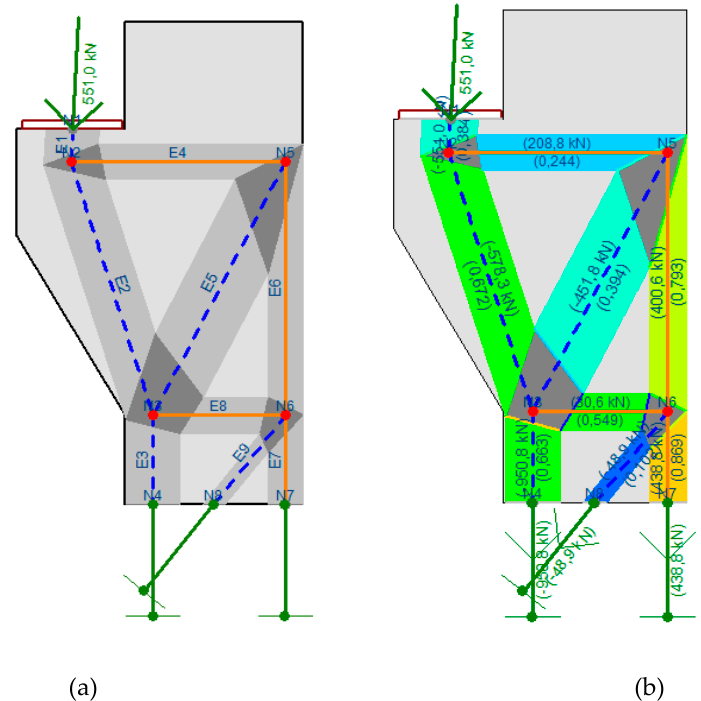
Figure 11. Strut-and-tie model: ( a ) proposed and ( b ) obtained results considering design forces Figure 11. Strut ‐ and ‐ tie model: ( a ) proposed and ( b ) obtained results considering design forces and and materials.